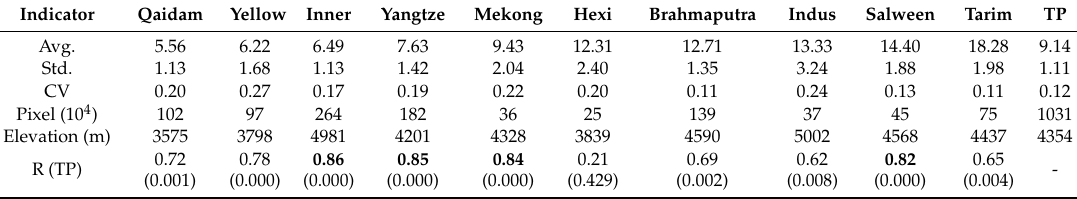
whole, the inter-annual variations of the di ff erent subregions are highly inconsistent. Table 5. The snow cover variability on the TP and the 10 subregions during 2001–2017.